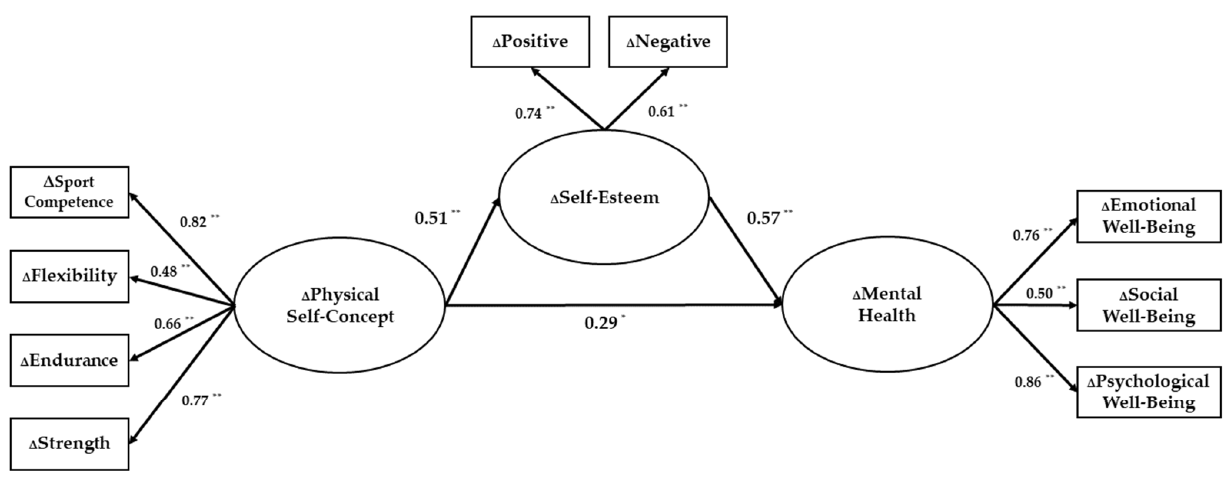
Figure 1. Relationship between change in physical self-concept, change in self-esteem, and change in mental health, * p < 0.05, ** p < 0.01.